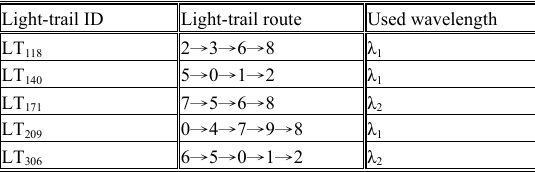
TABLE 7. The established light-trails in the optimal solution for scenario